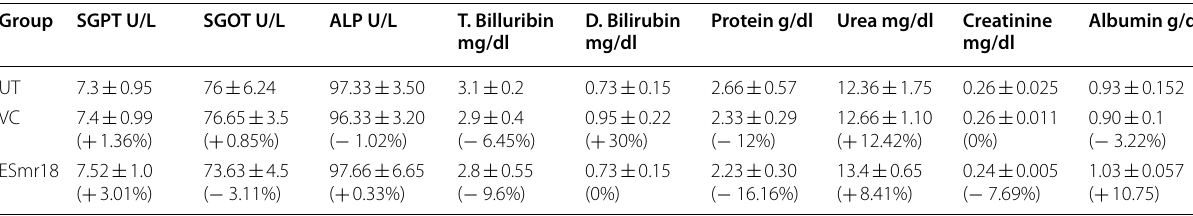
Data expressed as mean S.D. (n 6). UT: Untreated healthy control; VC: vehicle control; ESmr18: crude ESmr18 treated. Values in parenthesis are percent change over ± = control indicates decrease over control − indicates increase over control +